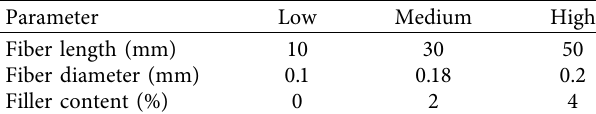
Table 1: Parameters and their